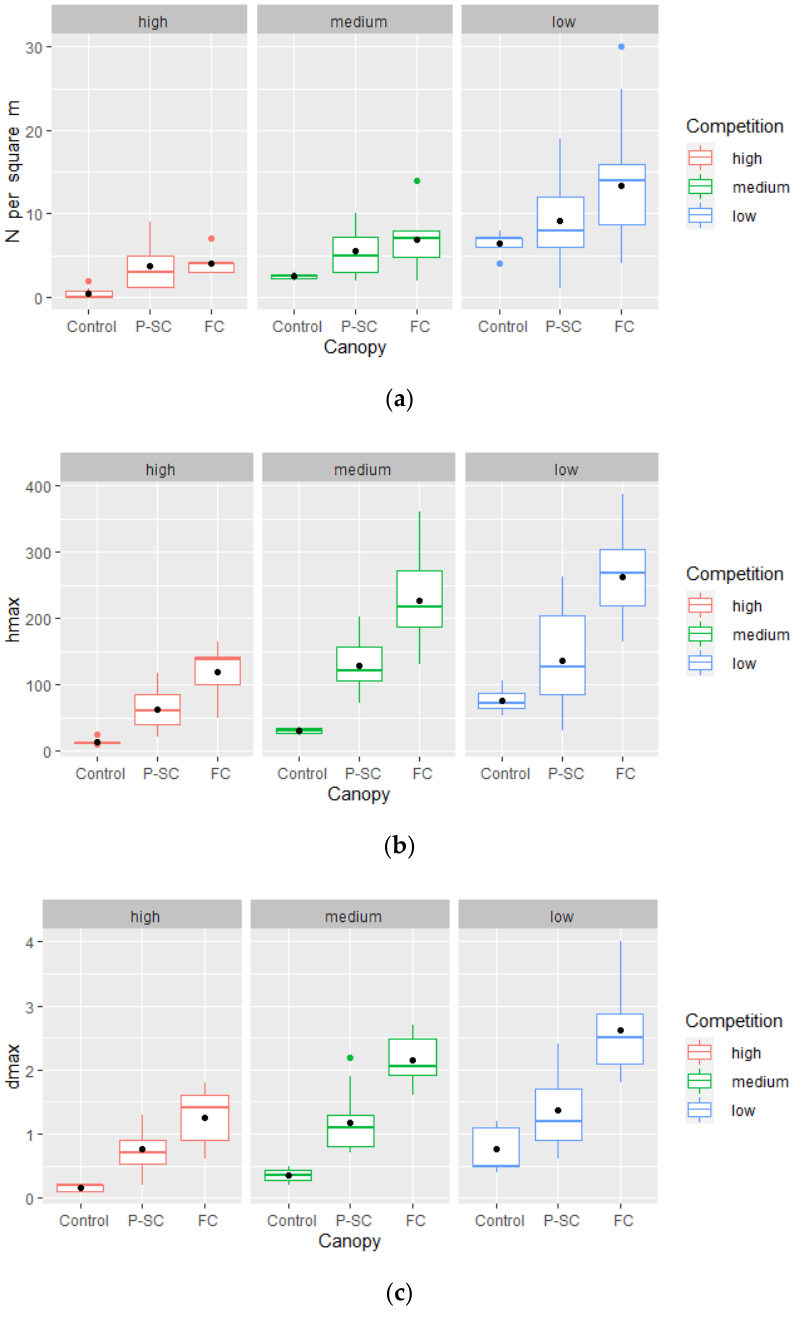
Figure 4. The number and growth characteristics of eight-year-old sessile oak seedlings depending on the canopy openness and the degree of competition. ( a ) The average number of sessile oak seedlings—N (per m 2 ). ( b ) The average maximum heights of sessile oak seedlings—hmax (cm). ( c ) The average maximum root collar diameters of sessile oak seedlings—dmax